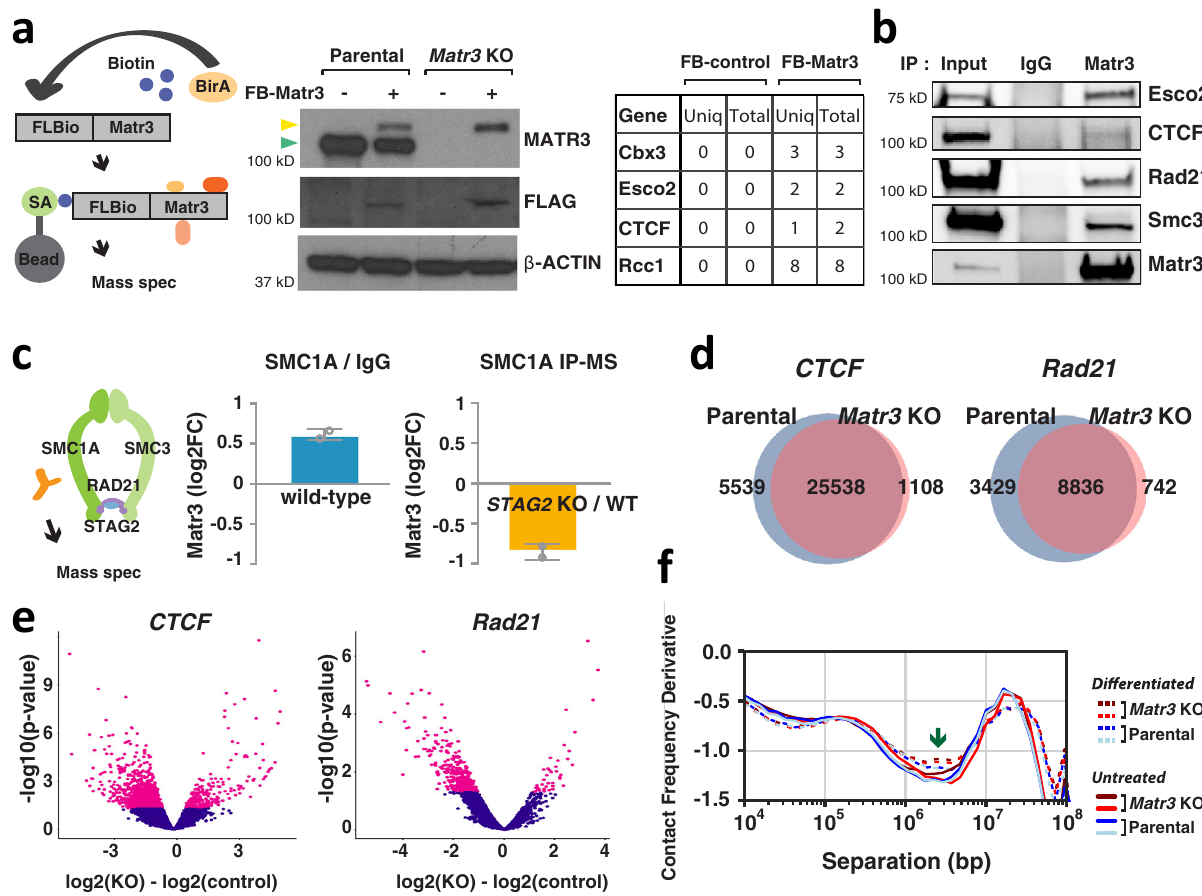
Fig. 4 Matr3 interacts with architectural proteins including CTCF and cohesin, and Matr3 loss alters their chromatin occupancy. a Parental and Matr3 KO MEL cells were engineered to express BirA and Flag-Biotin tagged Matr3. Western blot discriminated endogenous (green arrow) and/or biotinylated (yellow arrow) forms of Matr3 protein. Biotinylated form of Matr3 was recovered using streptavidin magnetic beads. BirA expressing cell was used as a control. From the result of mass-spectroscopy (MS) analysis (Fig. S3a), the number of unique and total peptides of the selected chromatin remodeling factors are shown in the table. Data were the result of 2 independent experiments. b Endogenous Matr3 protein was immunoprecipitated and its interaction with other proteins was examined by Western blot. Data were the result of 2 – 3 independent experiments. c The Smc1a subunit of the cohesin complex was pulled down in Stag2 wild type (WT) and KO U937 cells and subjected to mass-spectroscopy (MS) 80 . (left) Matr3 interaction to the cohesin complex is revealed by log2FC of Smc1a and IgG immunoprecipitation (IP)-MS in Stag2 WT cells. (right) The disrupted Matr3 interaction on the cohesin complex in Stag2 KO is measured by log2FC of Smc1a IP-MS in Stag2 KO and WT cells. Error bars represent mean ± 1 s.d. across two independent experiments. d ChIP-seq datasets of CTCF and Rad21 in parental and Matr3 KO cells were quantitatively compared 38 . The results of at least two independent experiments were combined to generate a more stringent peak list. The numbers of speci fi c and shared peaks in each comparison are shown in the Venn diagram. e Differentially bound CTCF and Rad21 sites between parental and Matr3 KO cells were identi fi ed using 39 . Sites with p -values from the Wald test less than or equal to 0.05 are shown in red on the plot. f Genome-wide contact probability calculated from Hi-C data (Fig. S2k). Derivative plot of the contact probability curve suggests low cohesin density in Matr3 KO compared to parental cells. The fl atter minimum expected to be seen with a reduced level of cohesin occupancy is indicated by an